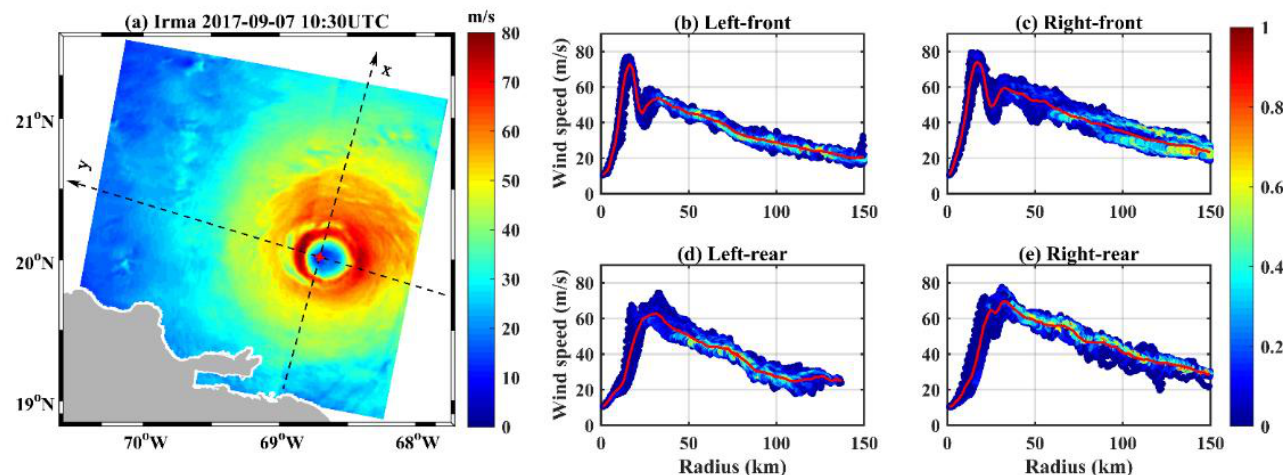
Figure 11. ( a ) SAR-derived wind field of Hurricane Irma (2017) using S1-A dual-polarization imagery acquired at 10:30 UTC on 7 September 2017, where the y-axis denotes the moving direction of Irma. ( b – e ) Wind speed distributions plotted as a function of hurricane radius and the mean wind profiles (red lines) in four TC quadrants, where the color bar denotes the normalized data density averaged in a 1 km × 1 km box. Each colored point is located at the center of the box.